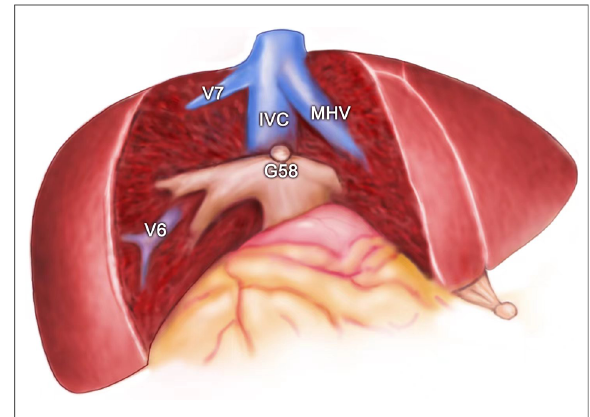
FIGURE 8 The view showing the MHV, IVC, V6, and V7 being exposed after segment 5 and segment 8 resection for HCC. MHC, middle hepatic vein; V6, vein of segment 6; V7, vein of segment 7; IVC, inferior vena cava; G58, Glisson ’ s 5 and